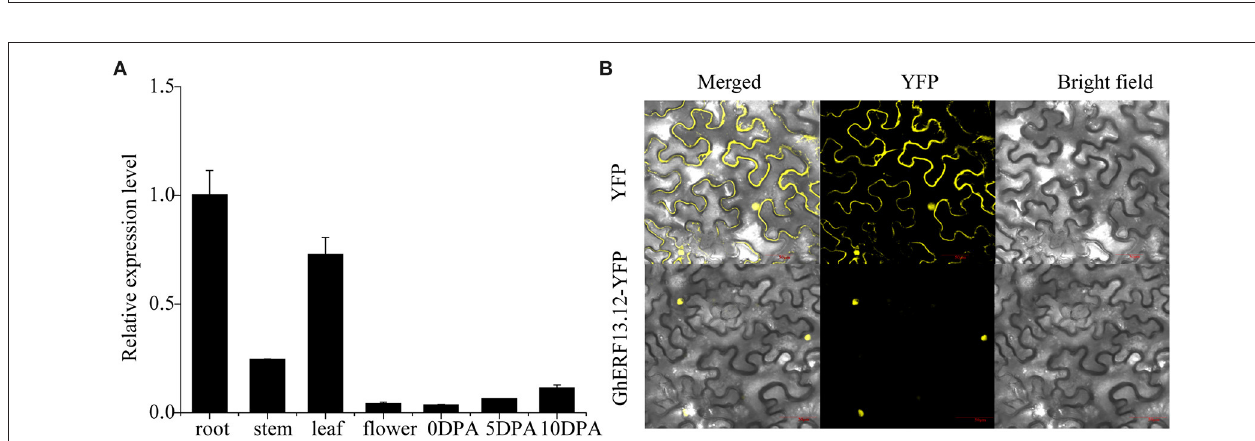
FIGURE 3 | Transcript analysis of the GhERF subfamily B3 group genes by salt stress treatment. The response of G. hirsutum ERF subfamily B3 group genes to salt stress was examined using real time fluorescent quantitative PCR analysis. The error bars correspond to the standard deviation among three biological replicates.